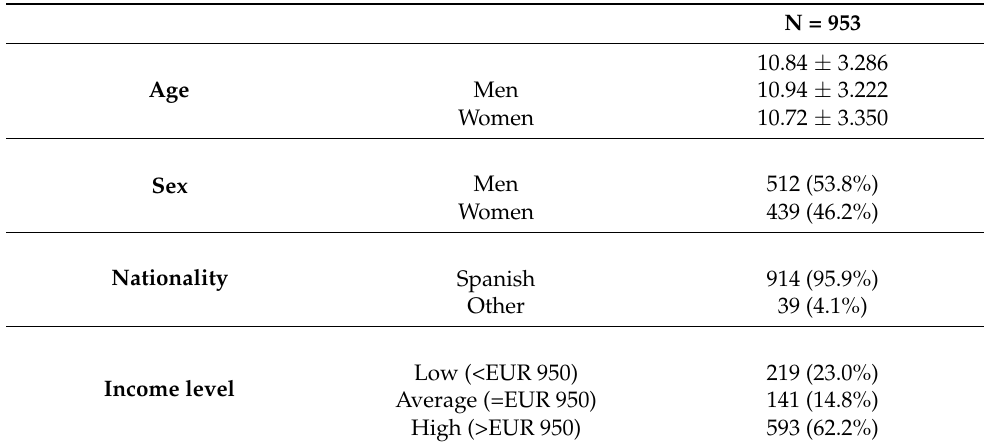
Table 1. Sociodemographic data of the